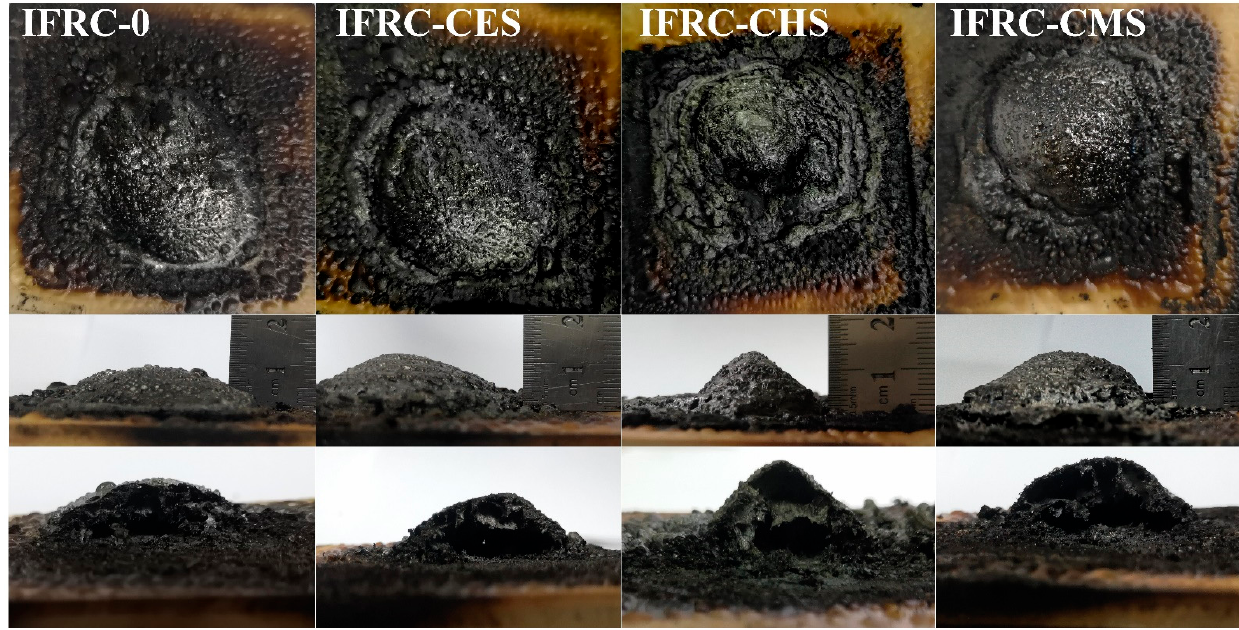
Figure 6. Photographs of the char residues obtained from the big panel method test.